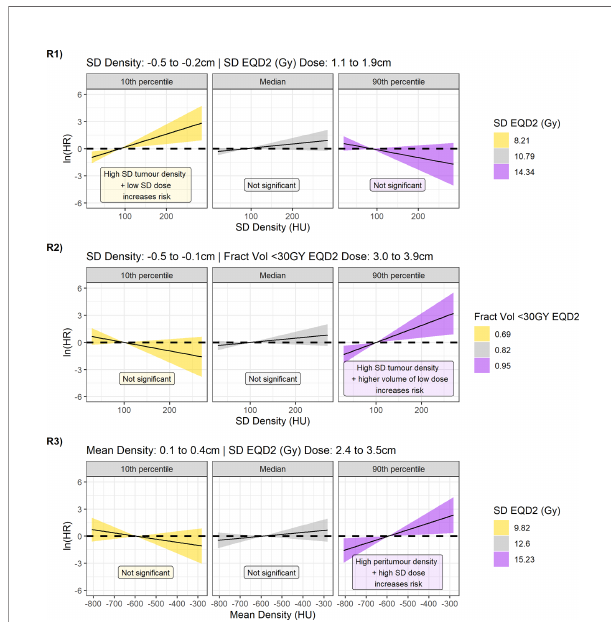
FIGURE 6 | Contrast plots for each of the models built displaying the log (hazard ratio) versus density at different values of the dose parameter. From top to bottom Regions 1, 2, and 3. Signi fi cant association between density and dose is only detected at low-dose variability in the 1.1- to 1.9-cm region, and high-dose variability and greater underdosage in the 2.4- to 3.9-cm region. In these cases, higher tumour variability and higher peritumour density are associated with increased